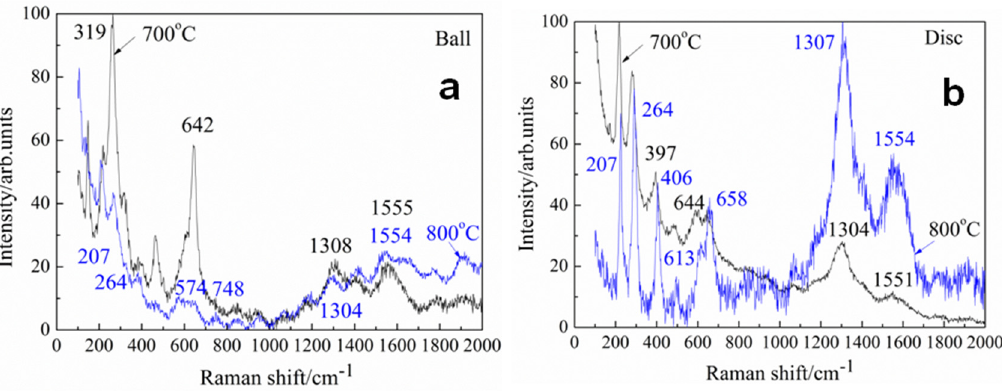
Table 1. Raman spectra of friction pair at 700 °C and 800 °C. FrictionPair Figure 13. Raman spectra of the worn surface at 700 °C and 800 °C: ( a ) ball and ( b )